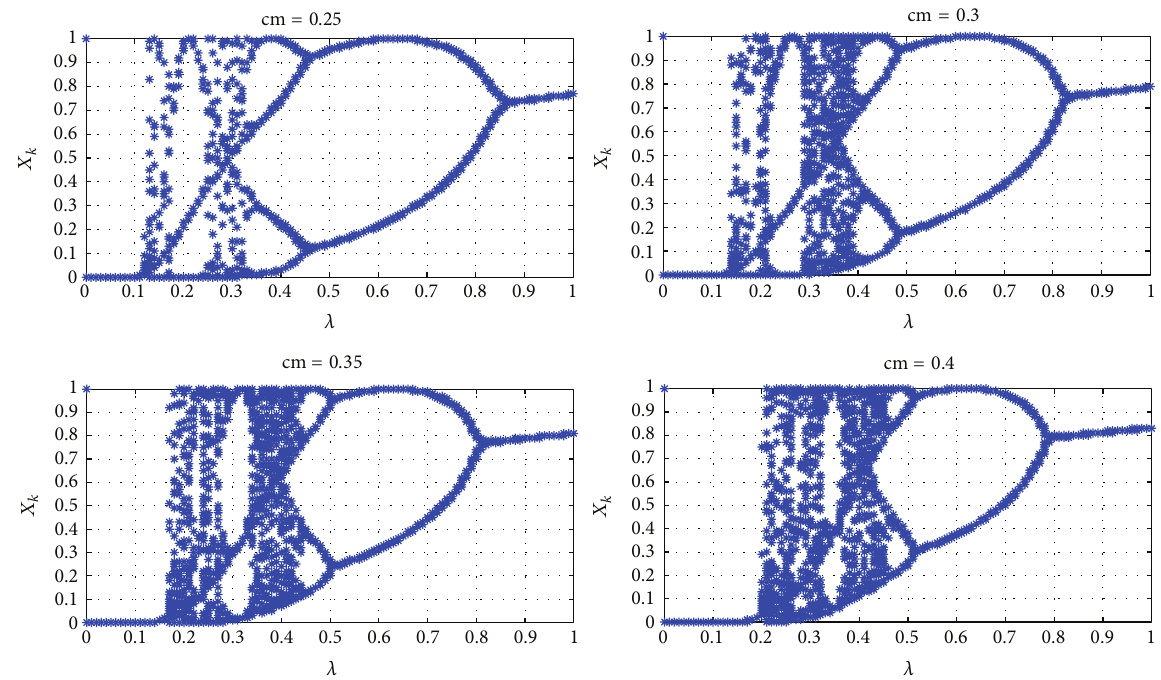
Figure 11: Bifurcation diagram using cm = 0.25 , 0.30, 0.35, and 0.40.